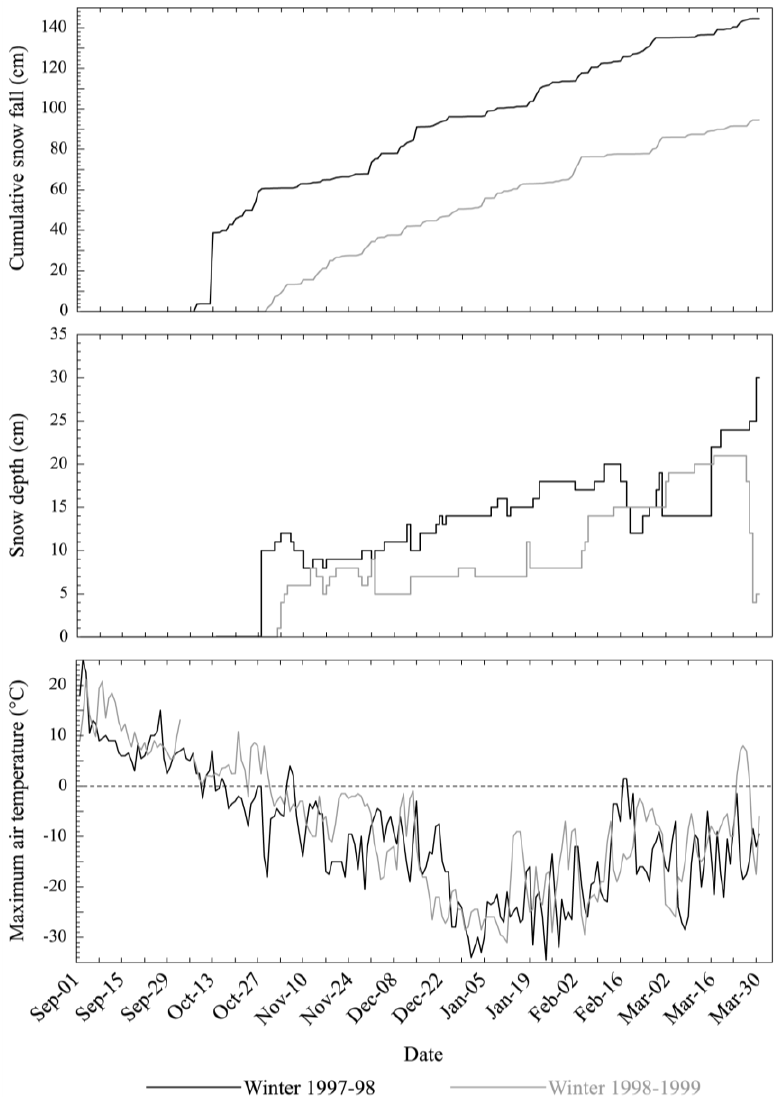
Figure 4. The cumulative snowfall, snow depth, and maximum air temperature observed at the Churchill Airport weather station from 1 September to 30 March, 1997/98 and